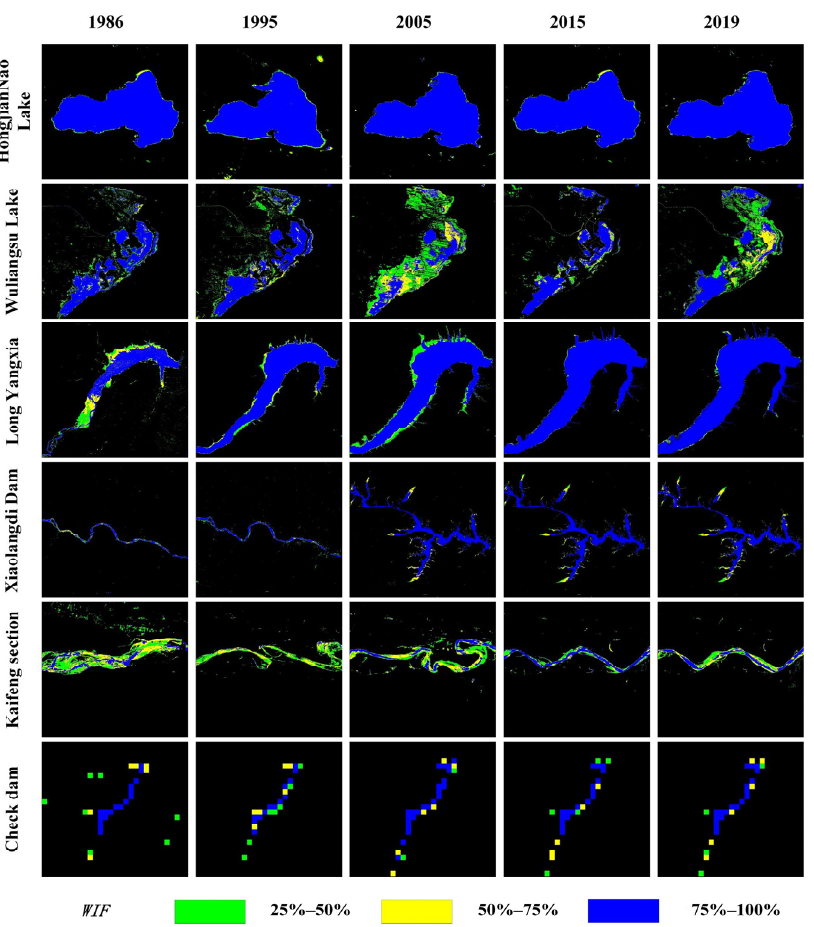
Figure 4. Variations in the WIFs of different types of typical water bodies in the YRB during 1986–2019. The classification accuracy of the surface water bodies derived using different WIF thresholds was validated based on selected samples of typical types of water bodies. The results show that the classification accuracies of the water bodies using WIF thresholds of 5%, 10%, 15%, 25%, 35%, 50%, and 75% were 97.33%, 97.23%, 97.17%, 97.12%, 97.00%, 96.86%, and 96.38%, respectively (Figure 5). The average value of the classification accuracy was as high as 97.01%, indicating that the surface water identification algorithm used in this study is very accurate and